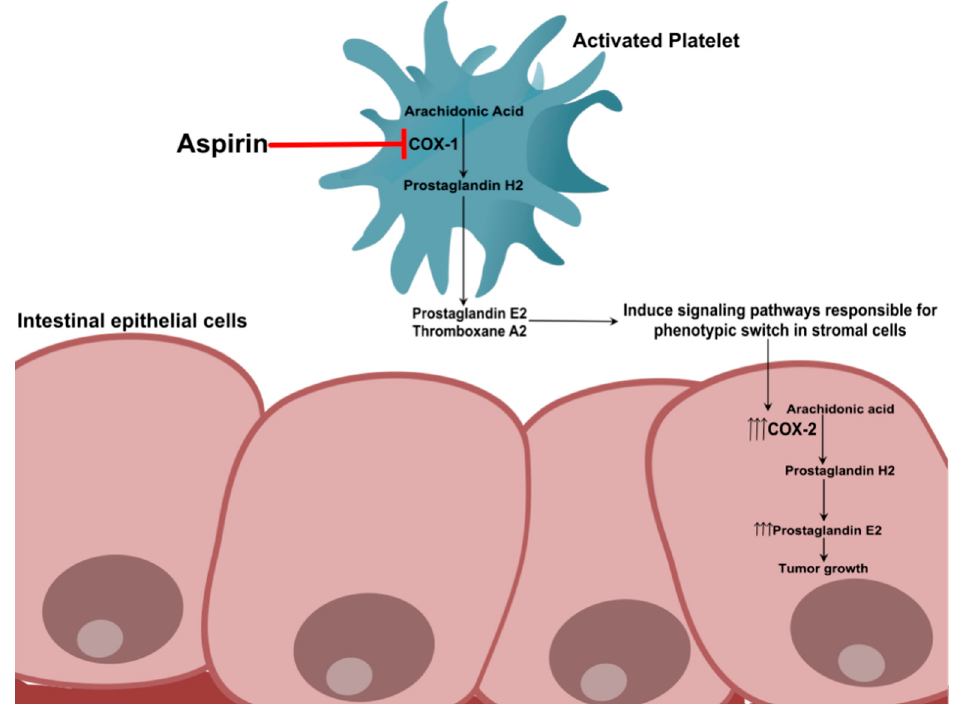
Figure 1. “Platelet hypothesis”. According to this model, platelet activation and aggregation at the site of intestinal mucosal injury is fundamental to tumorigenesis in the colorectal tissues. Activation of platelets can lead to the release of lipid mediators (e.g., prostaglandin (PG)E2) and growth factors (e.g., platelet derived growth factors (PDGF)) from platelets that in turn may promote stromal cell growth and induce cyclooxygenases (COX)-2 expression in intestinal cells of the colonic mucosa. Such events can further lead to increased PGE2 production resulting in hyperplasia, epithelial–mesenchymal transition (EMT) and transformation to a neoplastic phenotype [6,29]. It is hypothesized that central to the prevention of colorectal cancer (CRC) by aspirin is its ability to prevent platelet aggregation through inhibition of COX-1 leading to subsequent inhibition of thromboxane (TX)A2. Prevention of platelet aggregation blocks the release of lipid mediators and growth factors from platelets that otherwise induces the expression of COX-2 (in epithelial cells), which is implicated in tumorigenesis. This hypothesis thus states that sequential inhibition of COX-1 in platelets followed by inhibition of COX-2 expression in adjacent nucleated cells of the colorectal mucosa are important steps in aspirin’s cancer preventive actions.